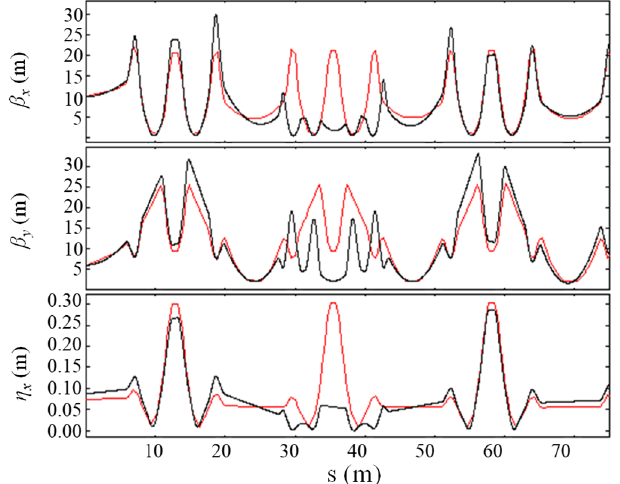
FIG. 5. Existing momentum aperture (black) vs new momen- tum aperture (cyan).